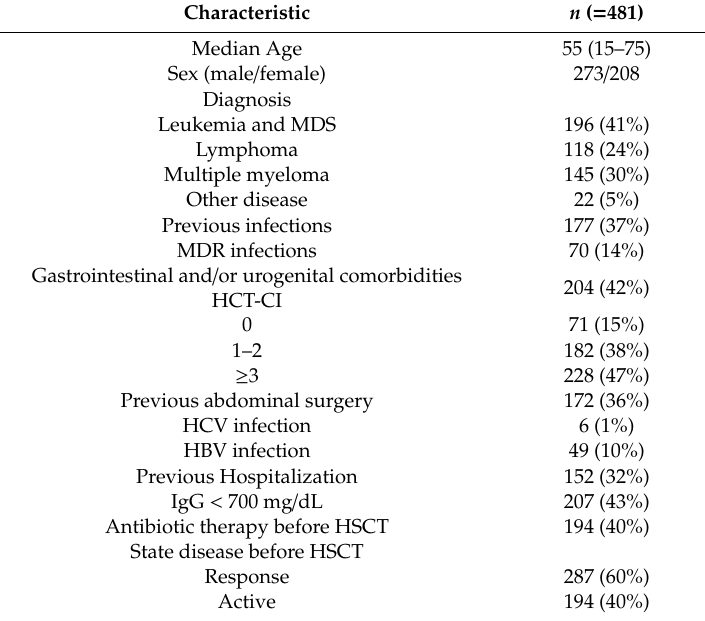
Table 2. Characteristic of